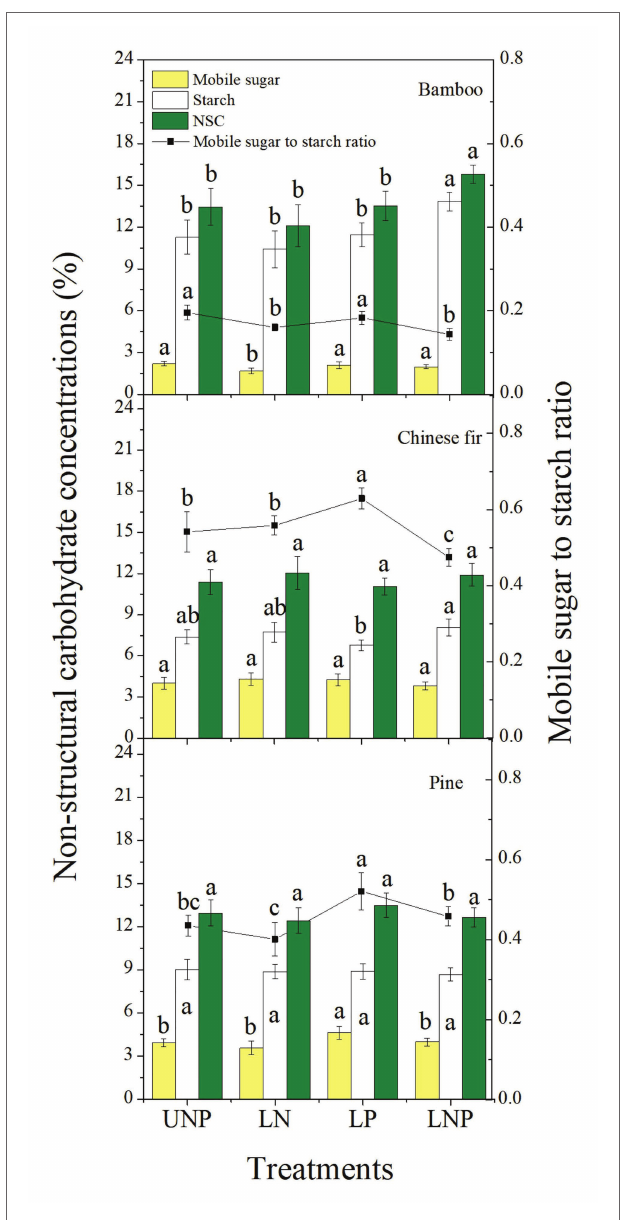
FIGURE 9 | Concentrations of non-structural carbohydrates (NSCs) and mobile sugar to starch ratio in roots of the three tree species grown under the four nutrient supply treatments. Different lowercase letters denote significant differences within the same category among treatments ( p < 0.05). NSC, non- structural